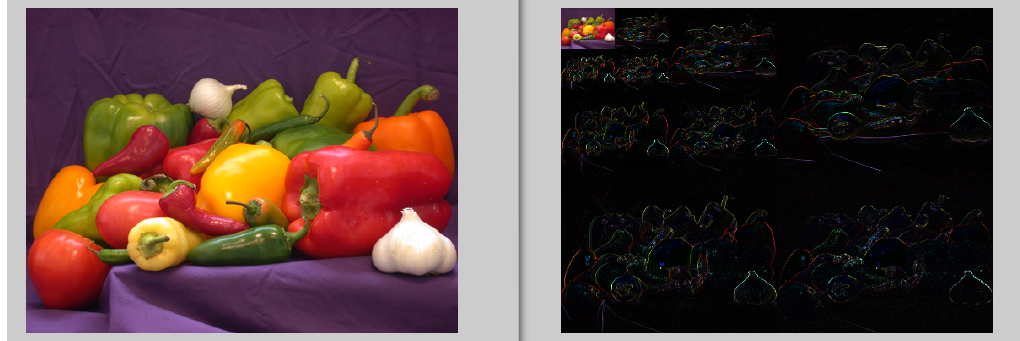
Figure 1. An image as example of a signal represented in traditional and wavelet